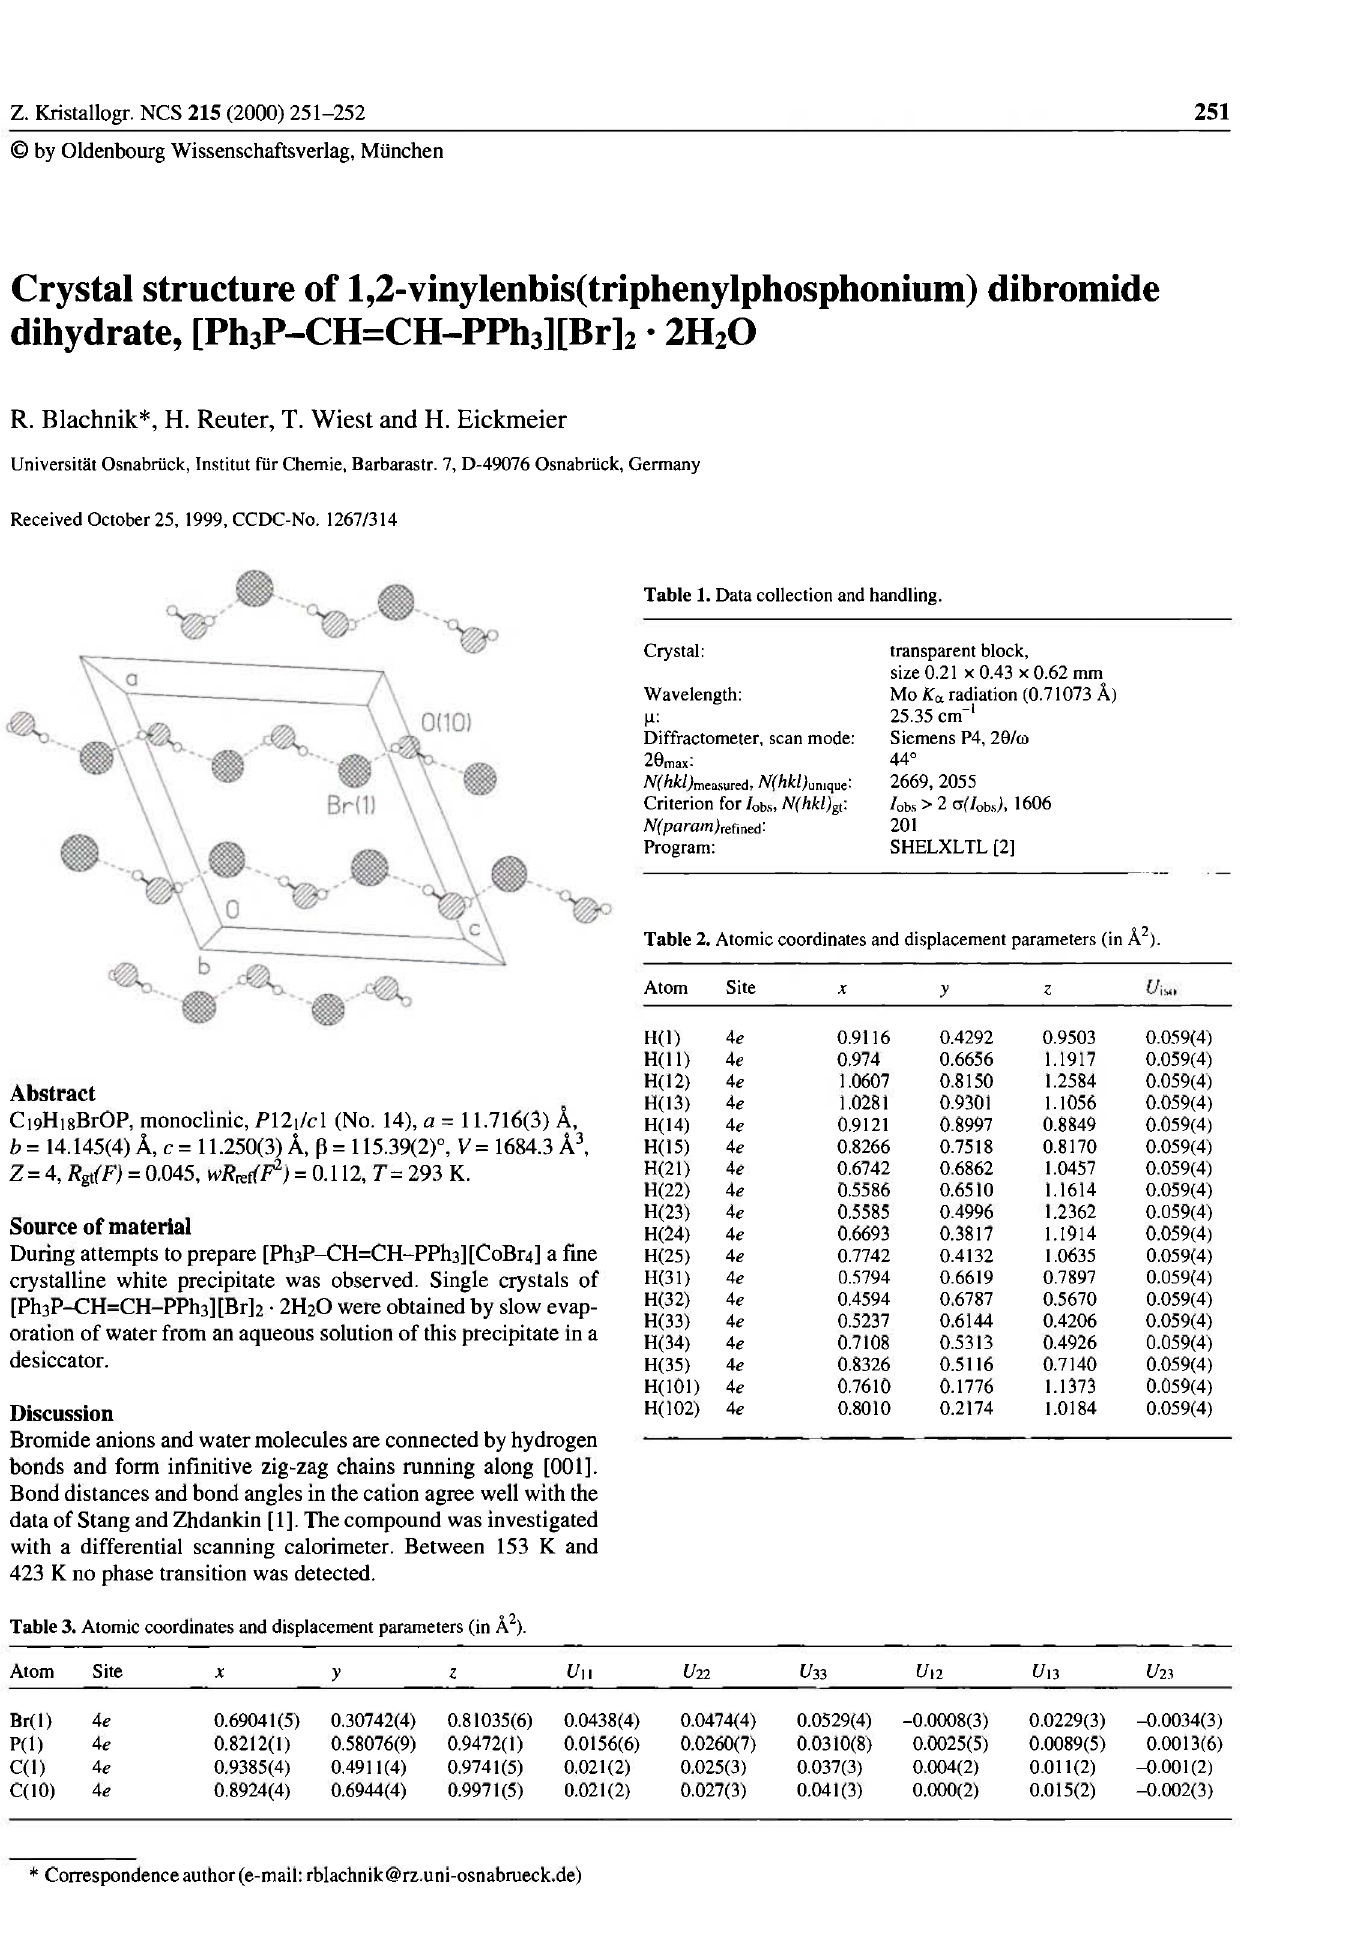
Table 3. Atomic coordinates and displacement parameters (in Ä 2 ).